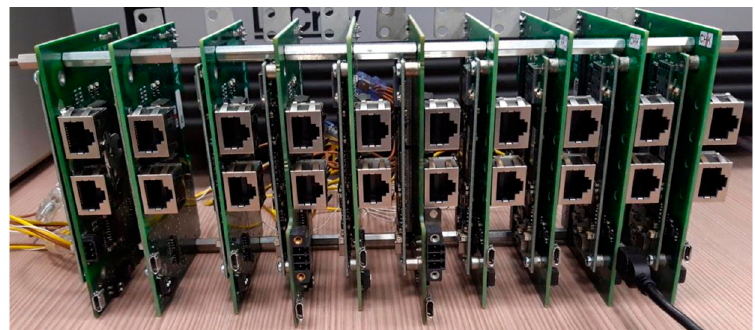
Figure 4. Experimental system setup: cluster of ten Power-One Italy S.p.A. a member of the FIMER Group inverters. Interconnections between inverters are not present.